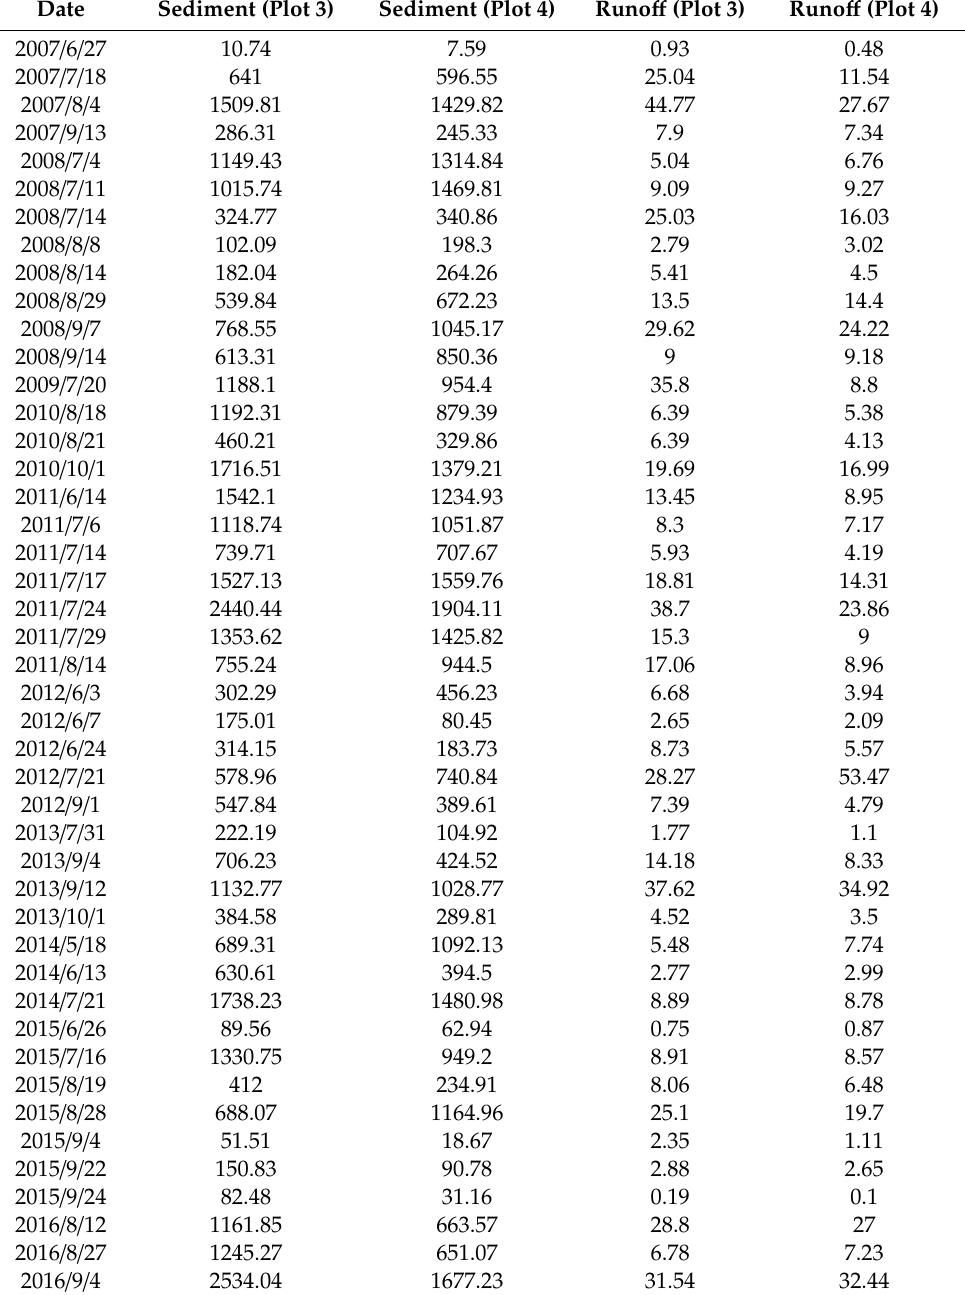
Table A3. The data set of runo ff